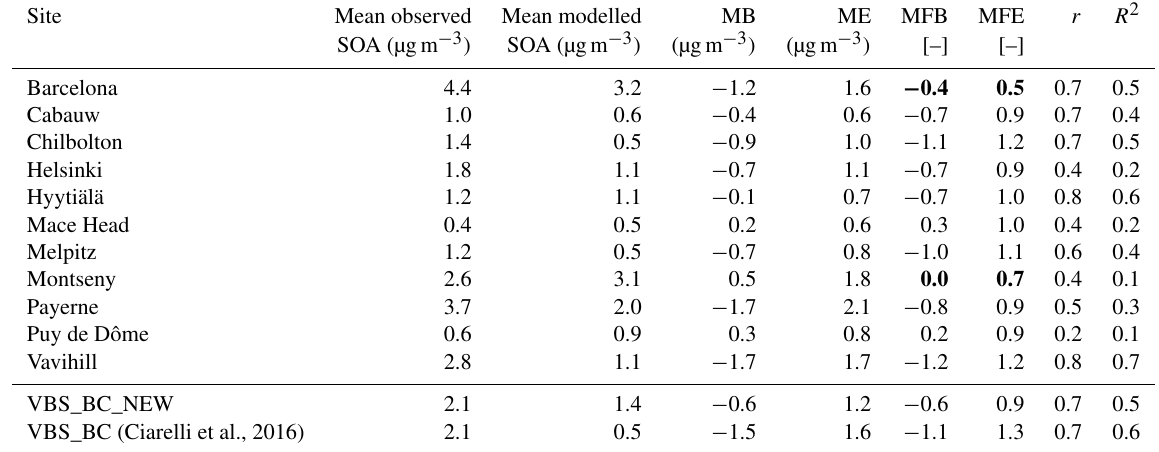
Table 4. Statistics of SOA for the VBS_BC_NEW case for February–March 2009 at each AMS site as well as an average of all sites for